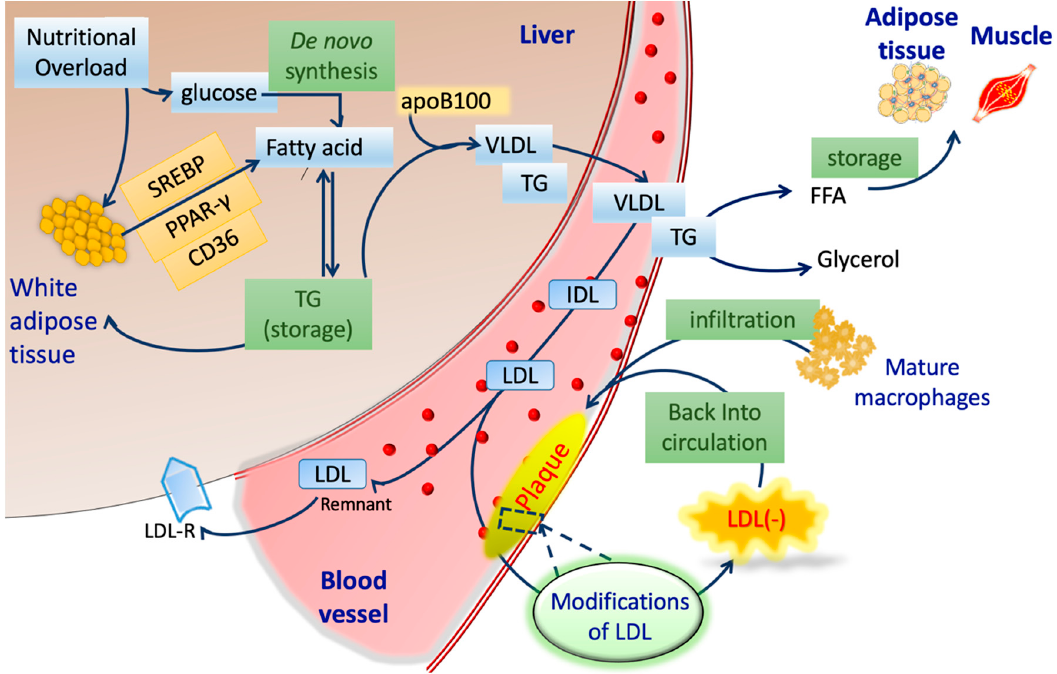
Figure 2. Schematic procedures of lipoprotein metabolism and LDL( − ) formation. SREBP: sterol regulatory element-binding protein; PPAR- γ : peroxisome proliferator-activated receptor; CD36: cluster of differentiation 36; TG: triglycerides; apoB100: apolipoprotein B100; VLDL: very low-density lipoprotein; IDL: intermediate-density lipoprotein; LDL: low-density lipoprotein; LDLR: LDL receptor; FFA: free fatty acid.